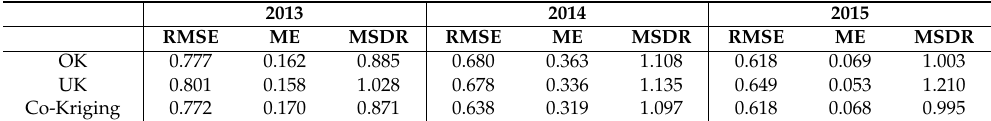
Table 4. Cross-validation holdout method results of soil Fe predictions. The root mean square error (RMSE), mean error (ME), and mean squared deviation ratio (MSDR) are referring to ln(Fe), for which Fe is in ppm.